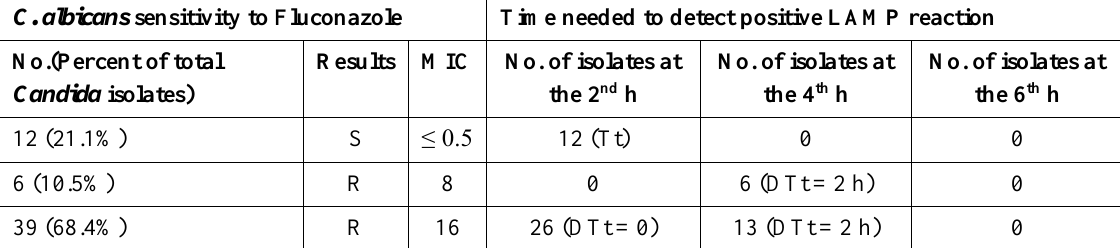
Table 4 . Time needed to detect positive LAMP reaction and its relation to fluconazole MIC values of C. albicans